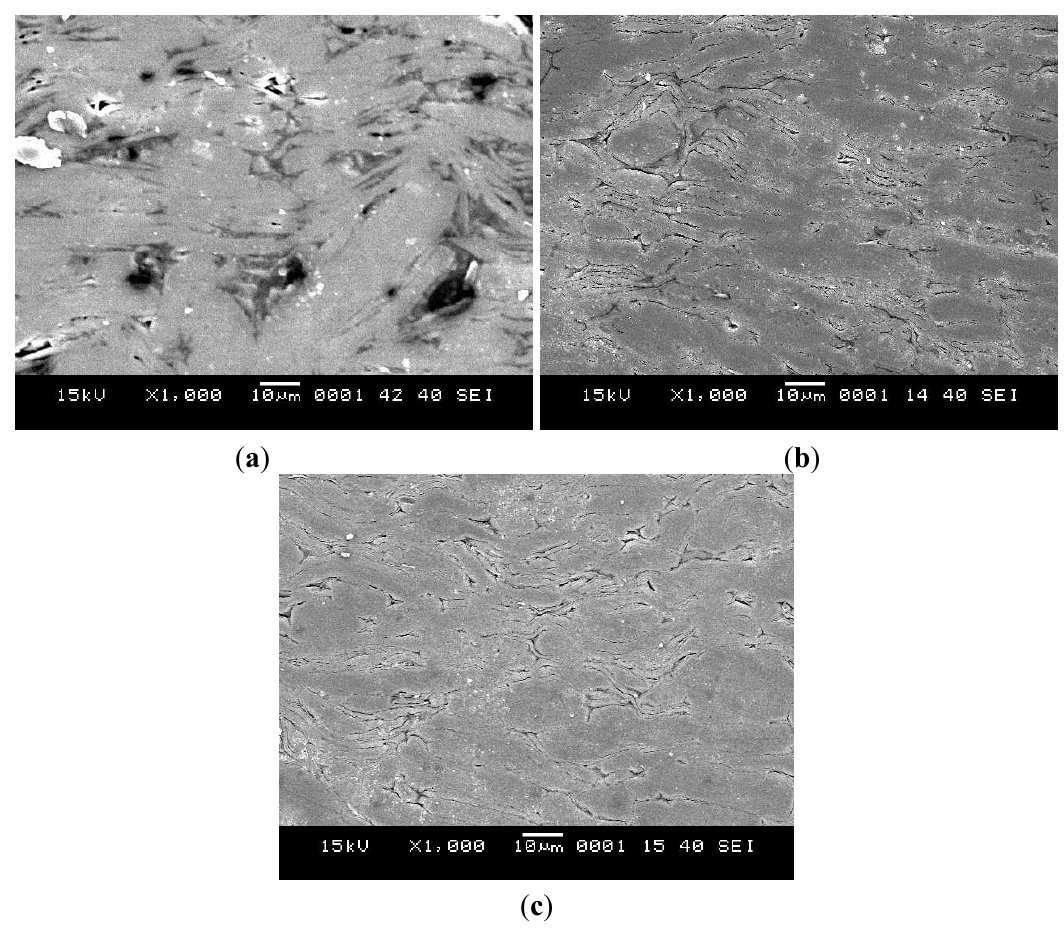
Figure 4. SEM micrographs of Al-1 wt% SiC sintered at ( a ) 550 °C, 5 min, 200 °C/min, 20 MPa; ( b ) 550 °C, 5 min, 200 °C/min, 50 MPa; ( c ) 550 °C, 5 min, 300 °C/min, 50